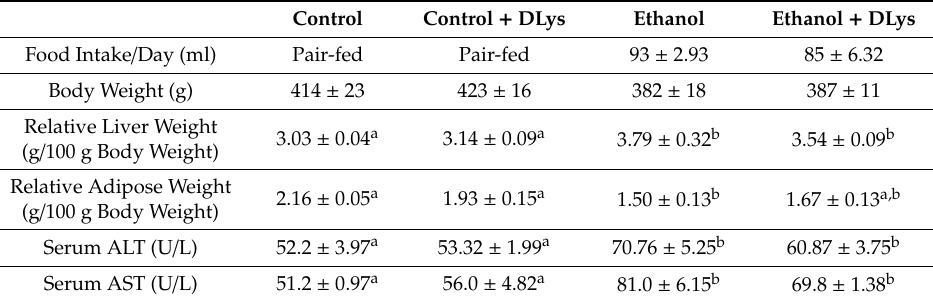
Table 2. Values of the selected parameters at